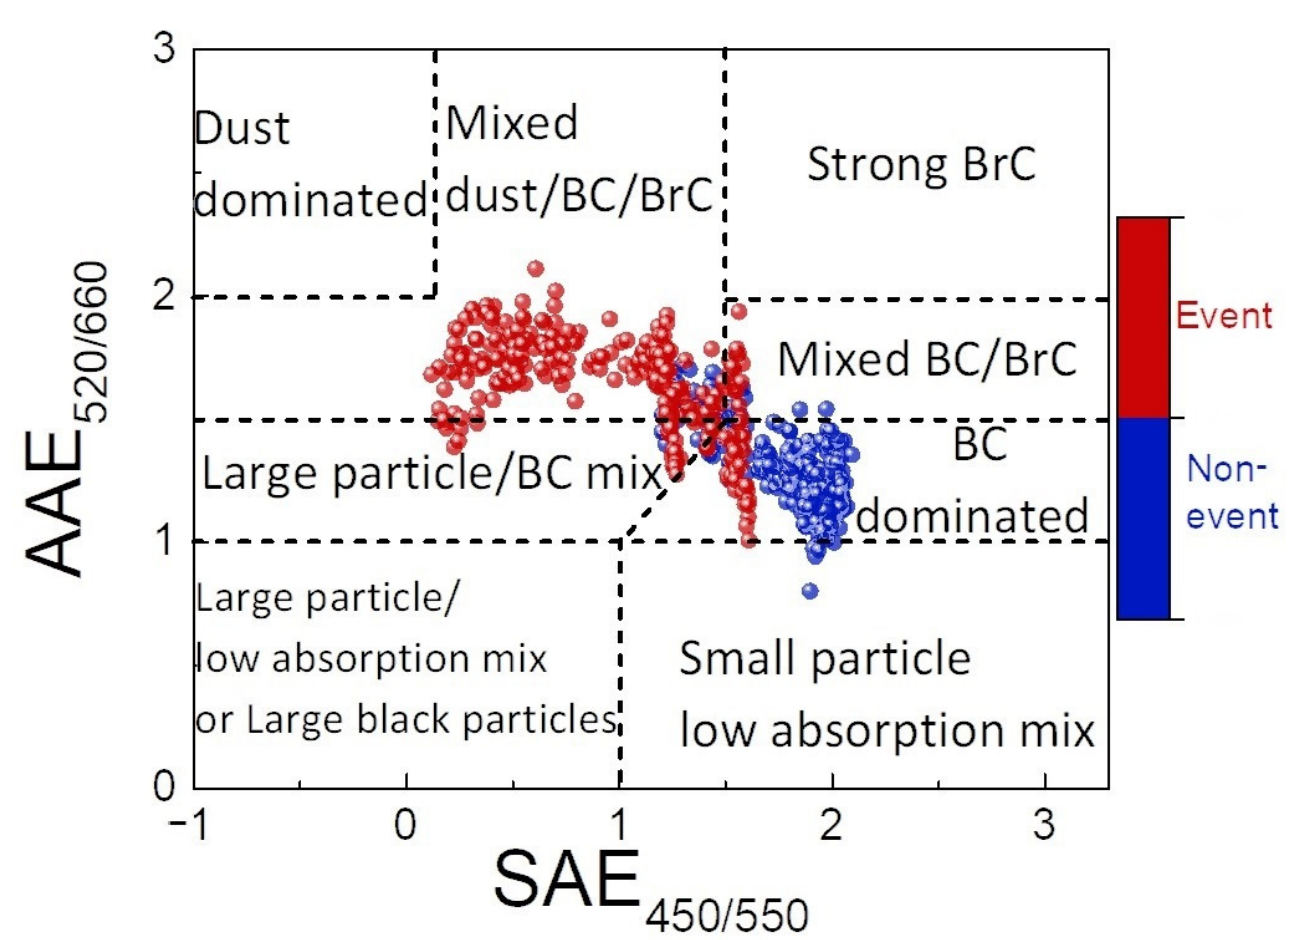
Figure 3. AAE and SAE space divided into segments based on Cappa et al. (2016). Blue dots represent non-event days, while red dots show data points during smoke event.